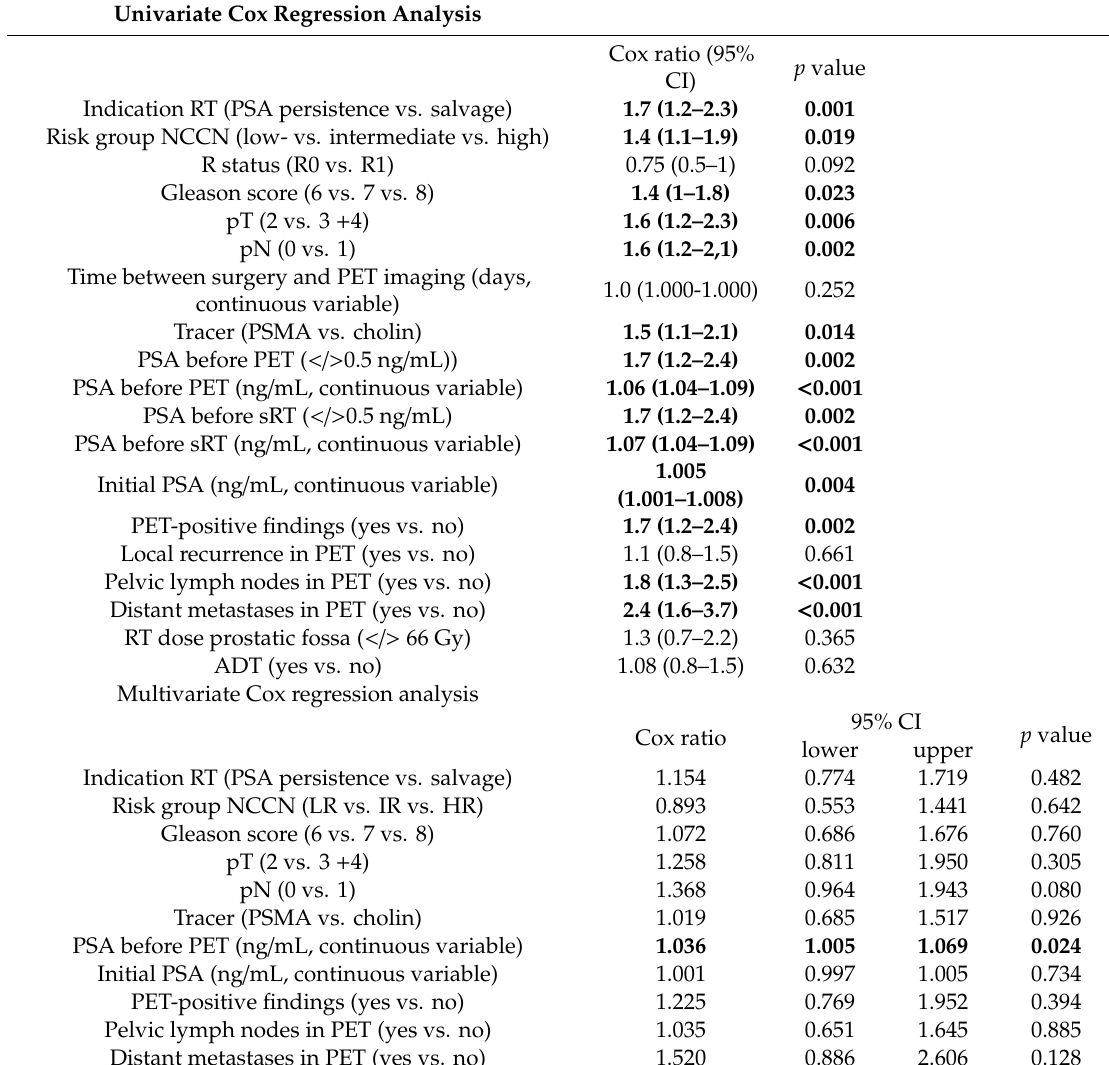
Table 3. Cox regression analysis for the entire